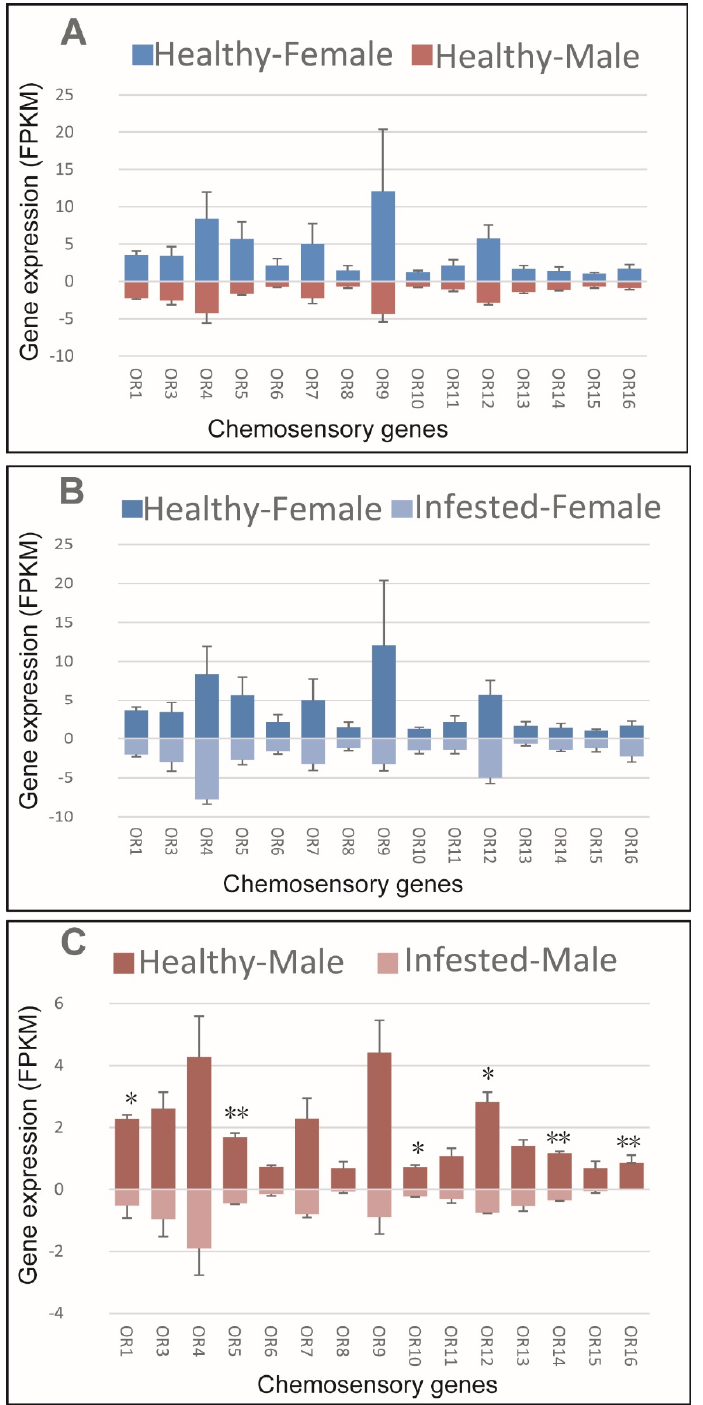
Figure 5. Expression patterns of olfactory receptors in healthy and B. xylophilus -infested M. saltuarius . ( A ) Differences between sexes of healthy M. saltuarius ; ( B ) Differences between healthy and infested female M. saltuarius ; ( C ) Differences between healthy and infested male M. saltuarius . Transcript levels are expressed as reads per kilobase of exon per million mapped reads (RPKM), and the expression data were shown as mean ± SE. The stars above each bar of figure indicate significant differences ( p < 0.05 * and p < 0.05